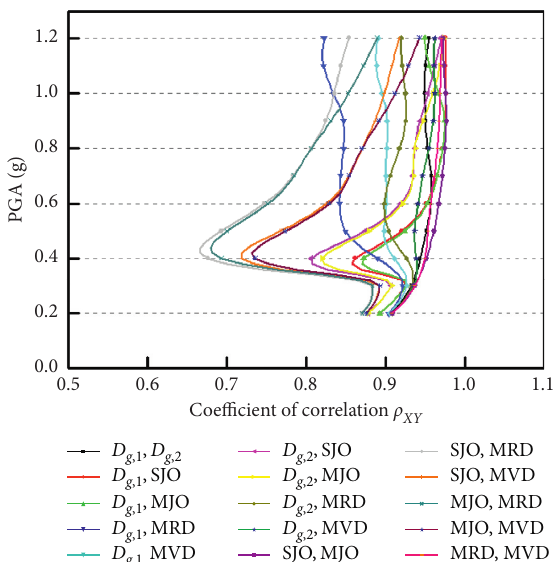
Figure 19: Coefficient of correlation at different earthquake intensities.